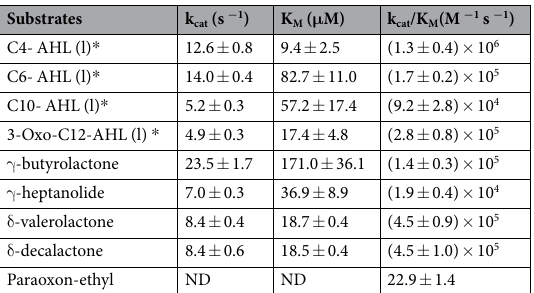
Table 2. Enzymatic characterization of the AaL enzyme. Related chemical structures of substrates are presented in Table S1. Kinetics were measured as quadruplicates, and standard deviation values are given for each parameter. The kinetics were performed in activity buffer (2.5 mM Bicine pH 8.3, 150 mM NaCl, 0.2 mM cresol purple, 0.5 % DMSO and with 0.2 mM CoCl 2 ). ND corresponds to not determined values because of too low catalytic rate. * Data from 34